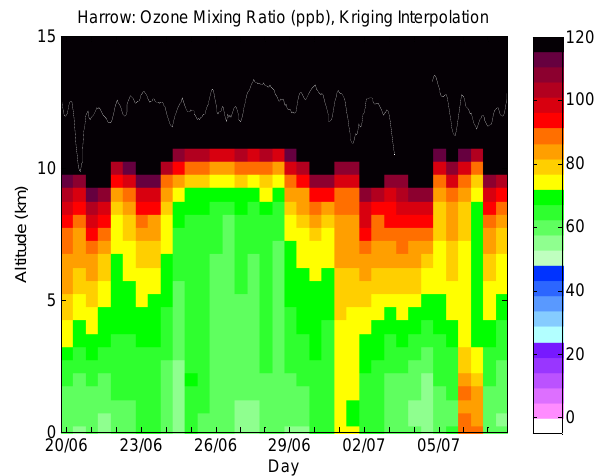
Figure 9: Kriging interpolation results at Harrow, Ontario (42.03ºN, 82.92ºW), using TES and AIRS ozone profiles. The red solid line shows the tropopause height derived from the radar data. Fig. 9. Kriging interpolation results at Harrow, Ontario (42.03 ◦ N, Date and time are UTC. 82.92 ◦ W), using TES and AIRS ozone profiles. The white solid line shows the tropopause height derived from the radar data. Date and time are